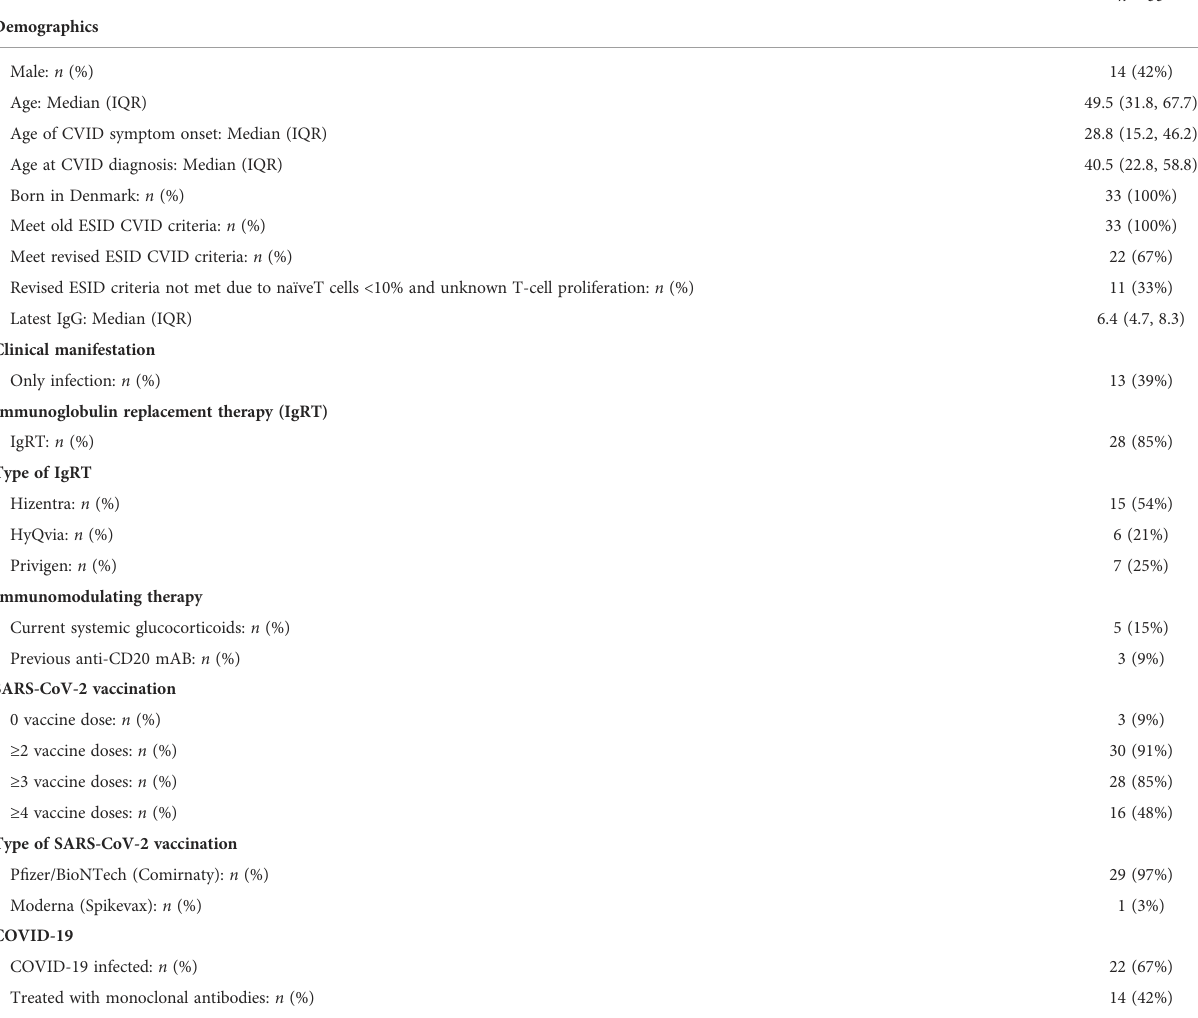
TABLE 1 Baseline characteristics of 33 study participants with common variable immunode fi